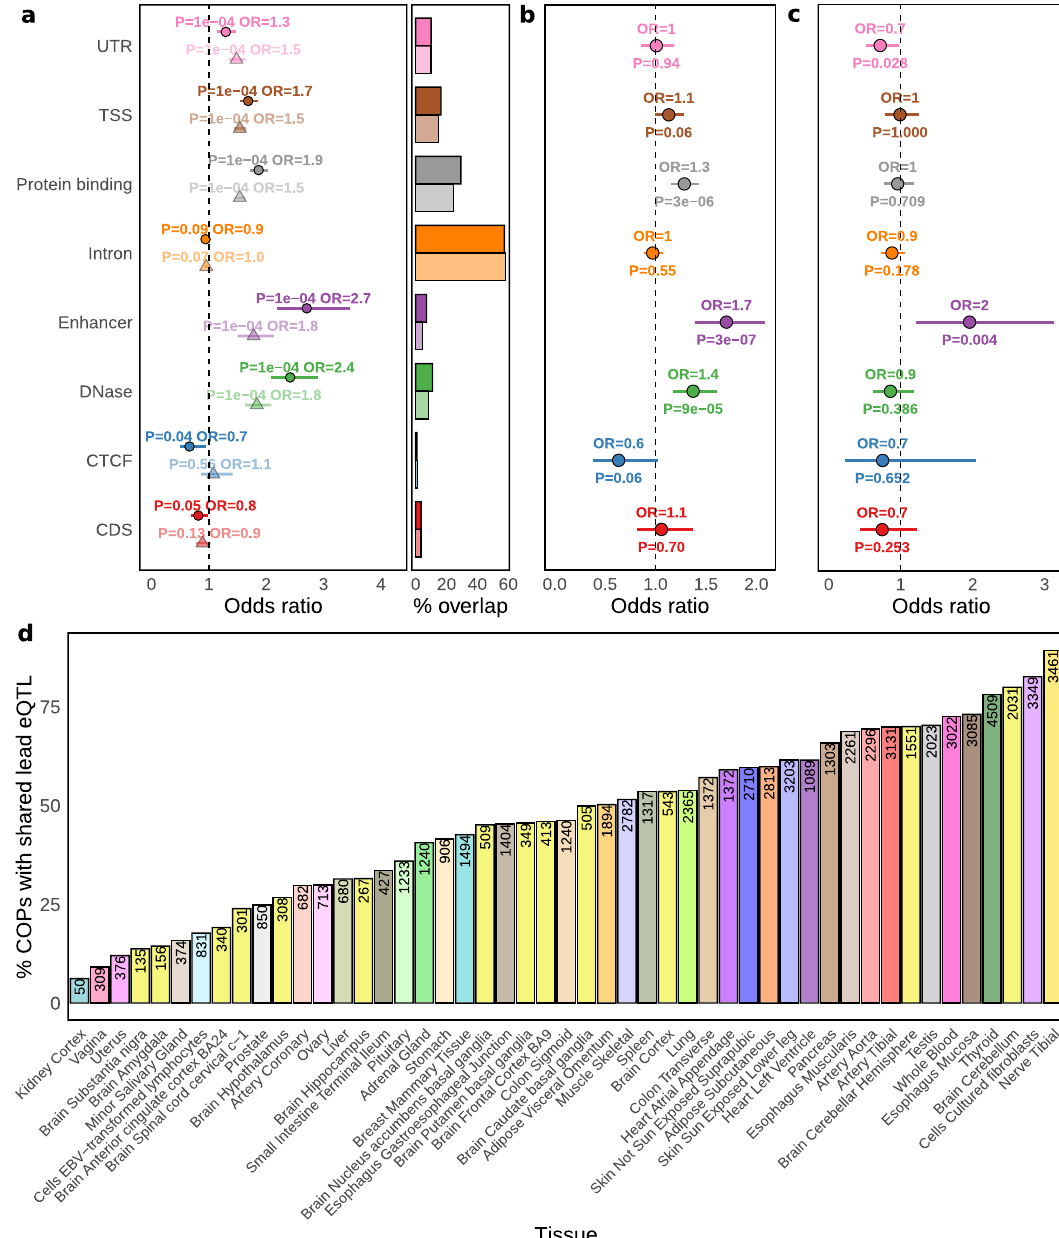
Fig. 4 Discovery and functional enrichments of shared eQTLs. a Overlap enrichment of Geuvadis LCL shared lead eQTLs (solid colour, round points) and other lead eQTLs (pale colour, triangles) in Encode LCL functional annotations and Gencode gene body categories (see the “ Methods ” section). Odds ratios are calculated based on the observed versus expected overlap (10,000 QTLtools Fenrich permutations; see the “ Methods ” section) between eQTLs and each functional annotation, through two-sided Fisher ’ s exact tests (no multiple test adjustment). Error bars are 95% con fi dence intervals. The right part of the plot denotes the percentage of overlap between eQTLs and each functional annotation. b , c Two-sided Fisher ’ s exact test odds ratio and p -value for the enrichment of shared lead eQTLs in each functional annotation compared to other lead eQTLs, for eQTLs in Geuvadis LCLs and GTEx LCLs, respectively. Error bars are 95% con fi dence intervals. d Percentage of COPs with a shared lead eQTL per GTEx tissue. Numbers inside bars denote the number of COPs with eQTL